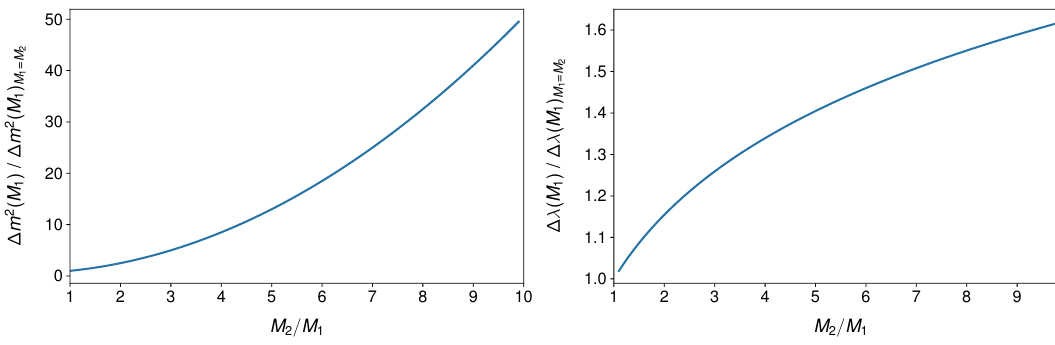
p Figure 2 . Relative variation of (cid:1) m 2 (left) and (cid:1) (cid:21) (right) assuming M 2 = xM 1 compared to the degenerate case, as a function of x